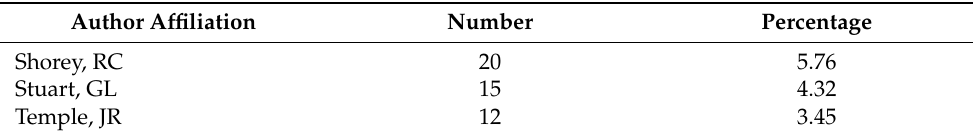
Table 6. Authors with the highest scientific production in the Scopus database.